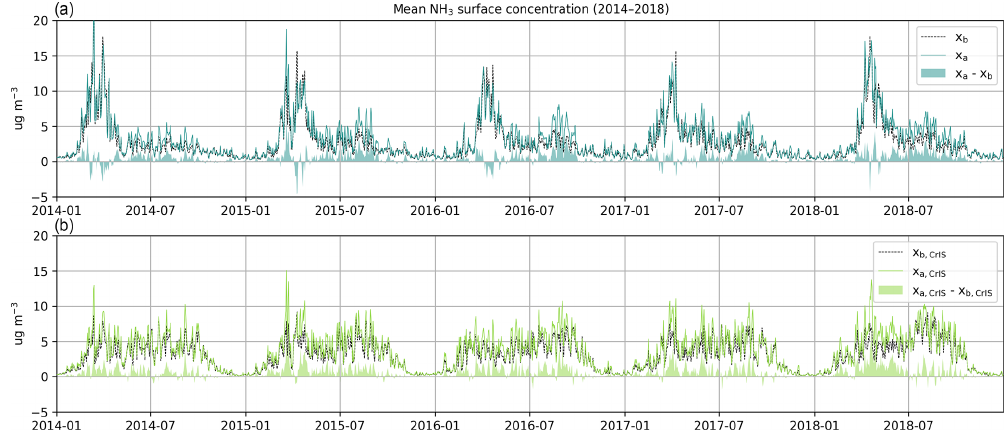
Figure 9. Time series of the daily grid-averaged NH 3 surface concentrations in the background and analysis runs, as well as their absolute difference. Panel (a) (blue) represents the default background ( x b ) and analysis run ( x a ). Panel (b) (green) represents the background ( x b , CrIS ) and analysis run ( x a , CrIS ) with the CrIS-based NH 3 time